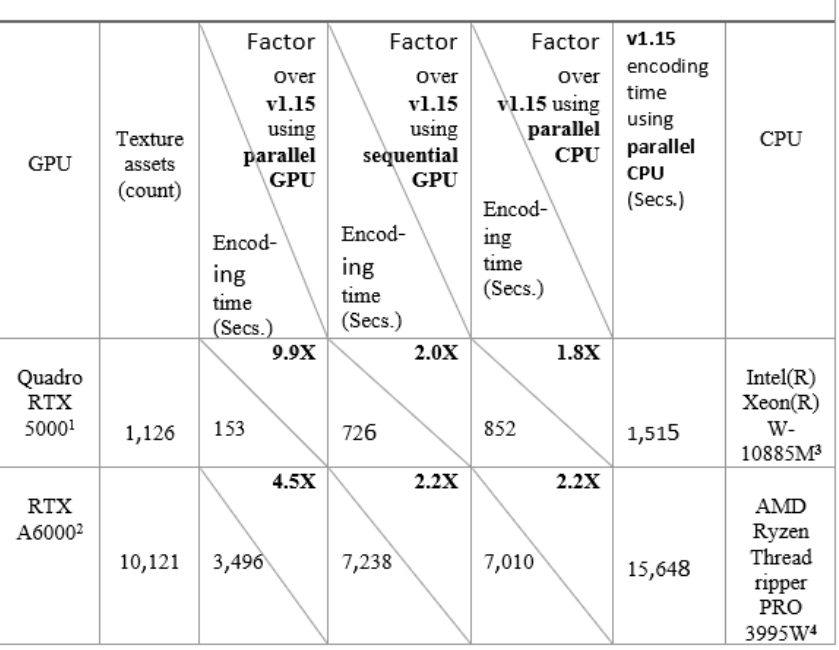
Table. 4 Compares the encoding optimization gained for the texture resources of an I3S dataset by leveraging the GPU using OpenCL™ to orchestrate parallel computation as well as CPU improvements gained in version 1.16 vs. 1.15 of the Basis Universal encoder